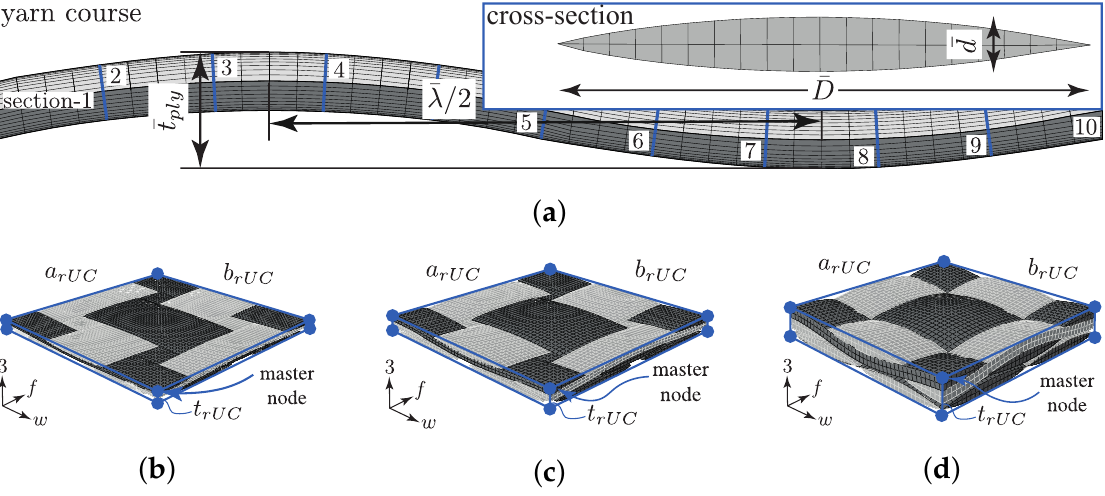
Figure 13. Illustration and notation of ( a ) geometry and mesh of the yarn course and cross-section as well as definition of sections (section-1, etc.) and rUC of ( b ) type I rUC MN ( d ) type III rUC MN (maximum nesting configuration; dimensions are not representative—normalised III to